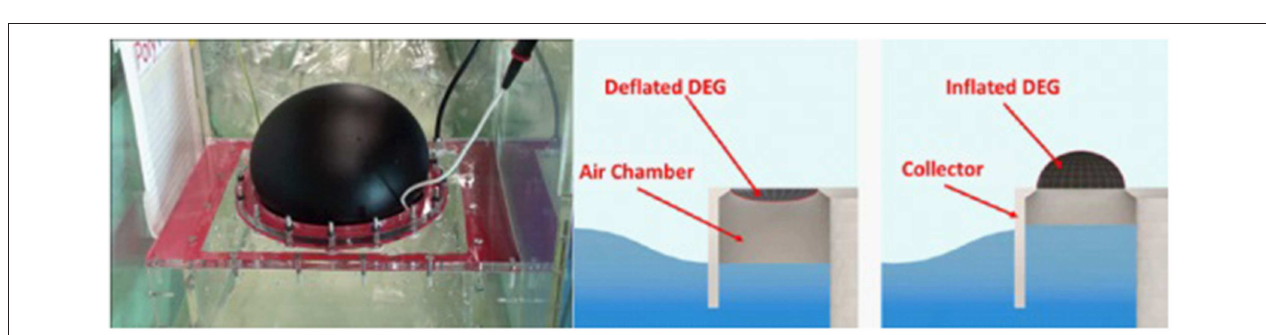
FIGURE 4 | Poly-OWC small scale device (Left) and schematic representation of Poly-OWC (Right) .